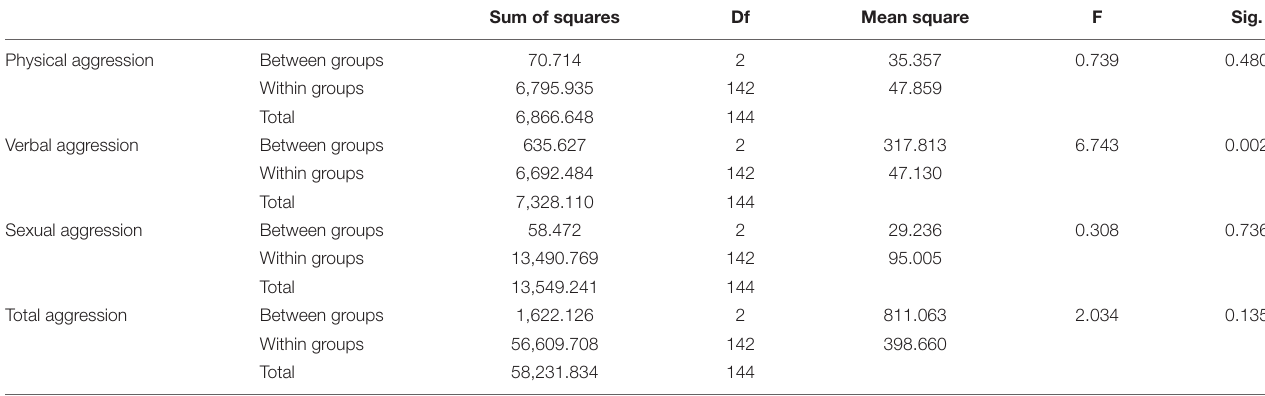
TABLE 3 | Comparison of the mean scores of group 1, group 2, and group 3 on physical aggression, verbal aggression, and sexual aggression. Sum of squares Df Mean square F Sig. 70.714